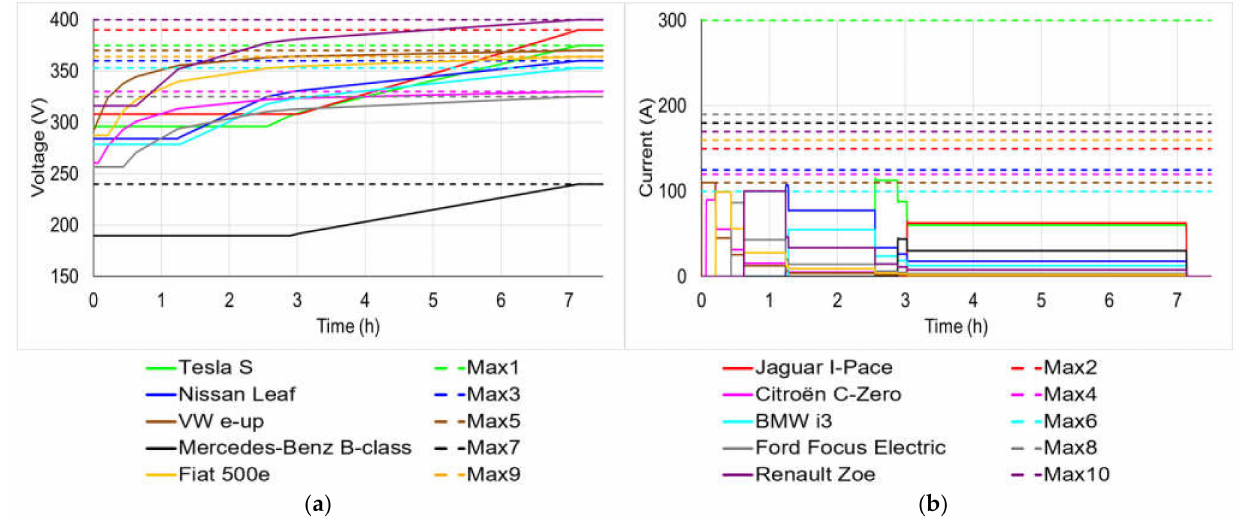
Figure 9. Battery terminal voltage ( a ) and current ( b ) of the EVs during charging using price premium priority.